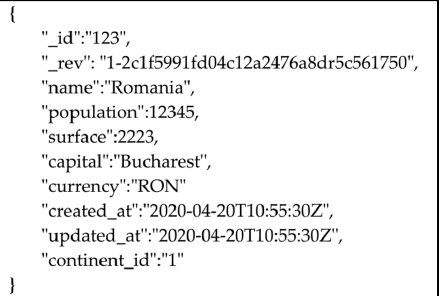
Figure 1. Relational database structure.